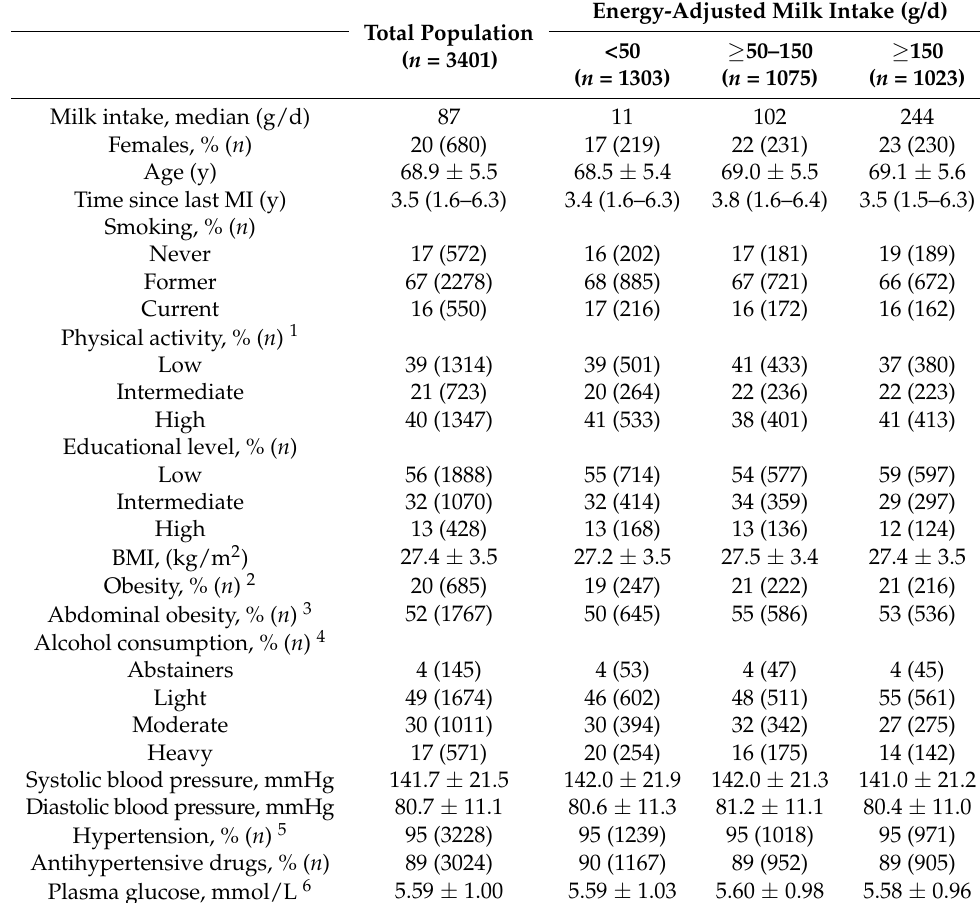
Table 1. Baseline characteristics of 3401 post-MI patients from the Alpha Omega Cohort, overall and across categories of energy-adjusted total milk